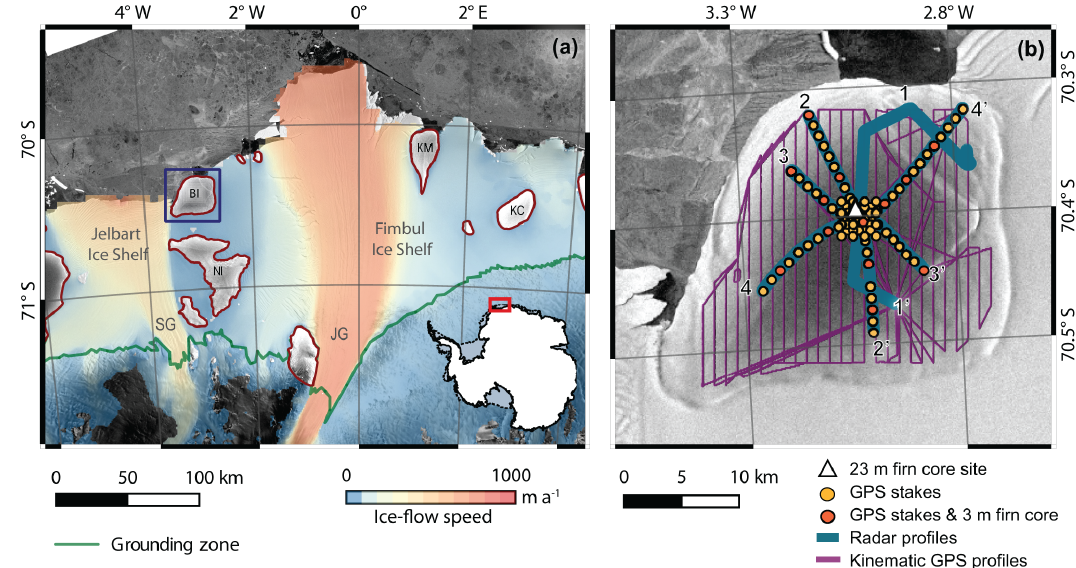
Figure 1. Blåskimen Island, western DML. (a) Blaskimen Island (BI in blue square) located between the Fimbul and Jelbart ice shelves. Inset shows the coverage of this map. Ice rises are outlined in red (Moholdt and Matsuoka, 2015), and the grounding zone of the ice sheet is illustrated in green (Bindschadler et al., 2011). The colour scale shows flow speed of the ice sheet and ice shelf (Rignot et al., 2011). The background of both panels is Radarsat-1 satellite imagery (Jezek et al., 2002). Acronyms stand for BI: Blåskimen Island, JG: Jutulstraumen Glacier, KM: Kupol Moskovskij, KC: Kupol Ciolkovskogo, NI: Novyy Island, and SG: Schytt Glacier. (b) Close-up view of Blåskimen Island. Pink curves show kinematic GPS profiles used to determine the surface topography and blue curves show radar profiles. Yellow circles show GPS stake positions for ice-flow measurements. Red circles show GPS stake positions where a 3m long firn core was also drilled. The white triangle shows the location where the 23m long firn core was drilled. Maps are projected to the Antarctic Polar Stereographic view